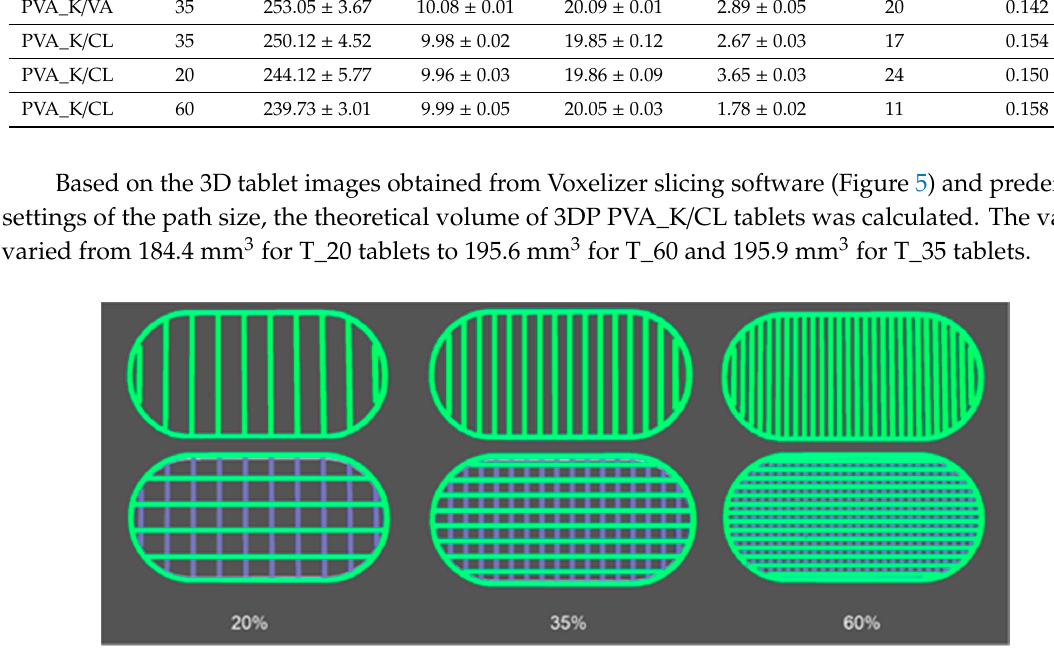
Table 4. Parameters of 3D printed tablets.